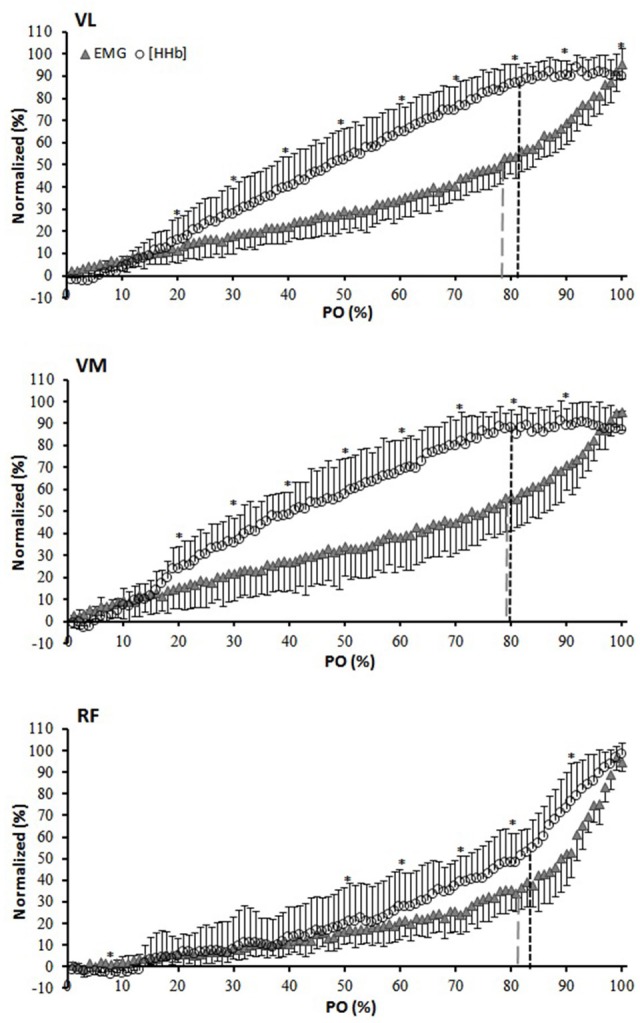
Normalized (0–100% of the amplitude) group average for [HHb] and EMG expressed as a percent of the normalized (0–100% of the response) power output (PO) for the vastus lateralis (VL), vastus medialis (VM), and rectus femoris (RF) muscles. *[HHb] significantly different from EMG. Black and gray dashed lines indicate breakpoints in the [HHb] and EMG profiles, respectively.